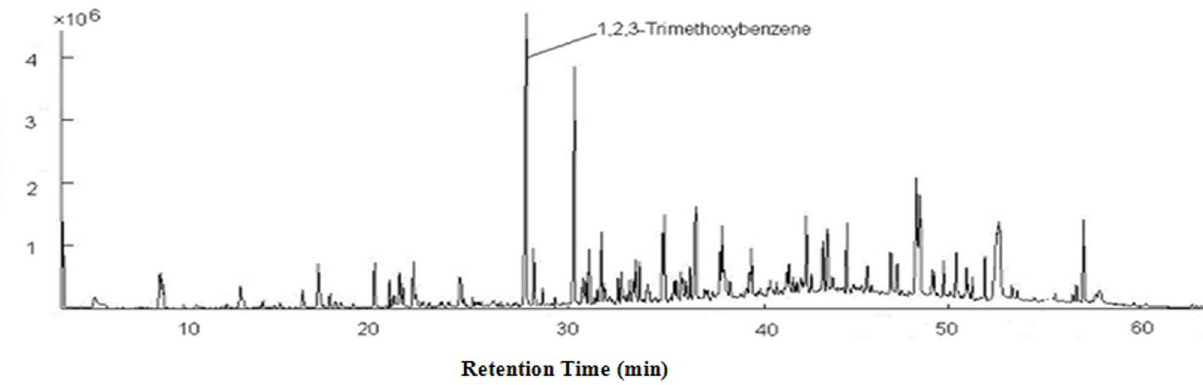
Fig. 2. The mean fingerprint chromatograms of 7 Dayi Pu-erh tea samples, which represent common volatile components information of samples, and obtained by the fingerprint similarity evaluation